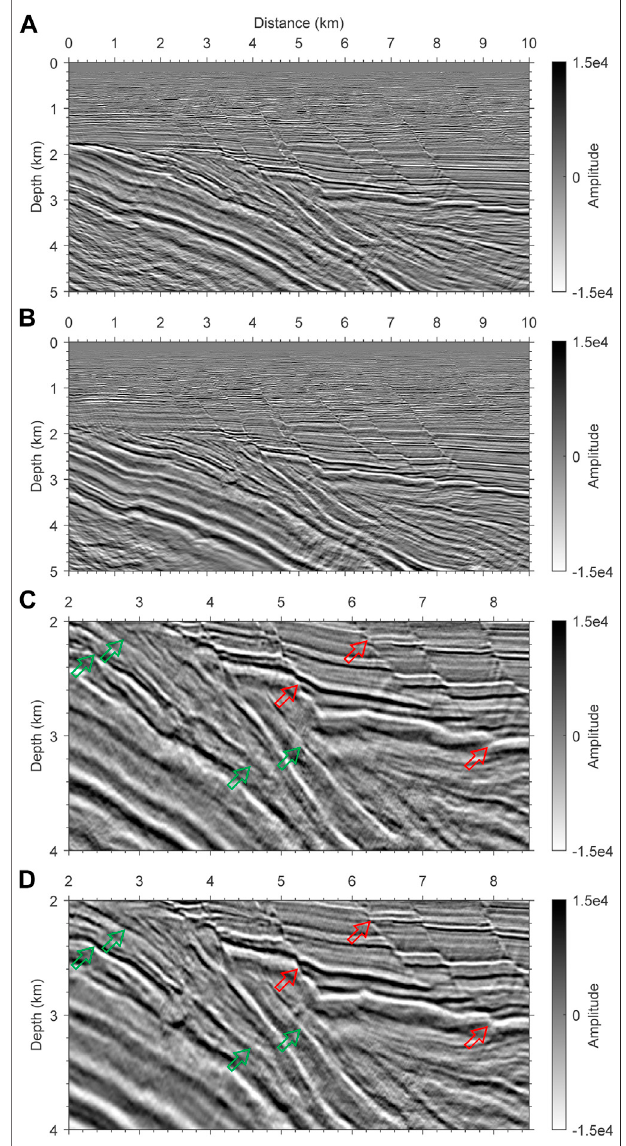
FIGURE15| TheKirchhoffPSDMmigrationimageswith (A) thestacking velocity and (B) the tomographic velocity. (C) and (D) are the enlarged view of the migration images shown in (A,B) , respectively. The red arrows indicate better-focused faults. The green arrows point out better-imaged re fl